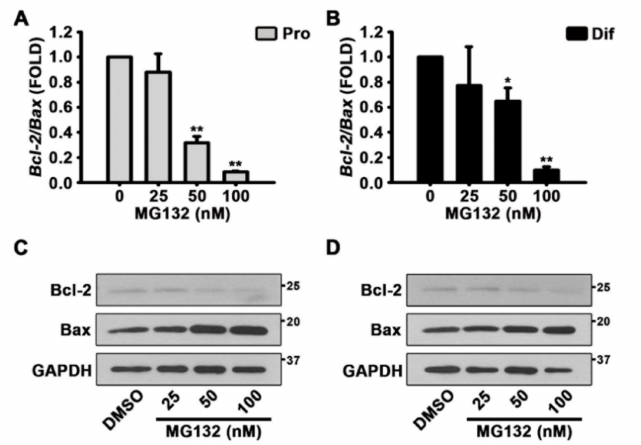
Figure 5. MG132 induces apoptosis by decreasing the B-cell lymphoma 2 (Bcl-2) / Bcl-2 associated X (Bax) ratio in NSCs. ( A , B ) After treatment with DMSO or various concentrations of MG132 (25–100 nM) for 48 h, total RNA from ( A ) proliferated or ( B ) di ff erentiated NSCs was isolated and subjected to reverse transcription-polymerase chain reaction (RT-PCR) to quantify Bcl-2 and Bax mRNA levels. Gapdh was used as an internal control. ( C , D ) Representative images of the protein bands of Bcl-2 and Bax. Two days after treatment, total cell lysates from ( C ) proliferated or, ( D ) di ff erentiated NSCs were subjected to western blotting analysis with Bcl-2 and Bax antibodies. GAPDH was used as a loading control. Data are expressed as mean ± SEM ( n = 3). * p < 0.05, and ** p < 0.01, (Student’s t -test).